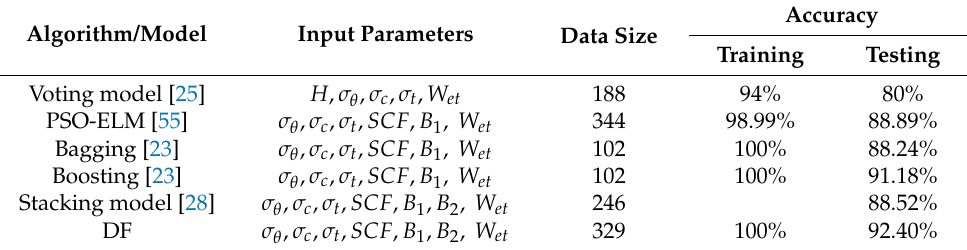
Table 13. Comparison of DF and other ML models proposed in recent years. Algorithm/Model Input Parameters Data